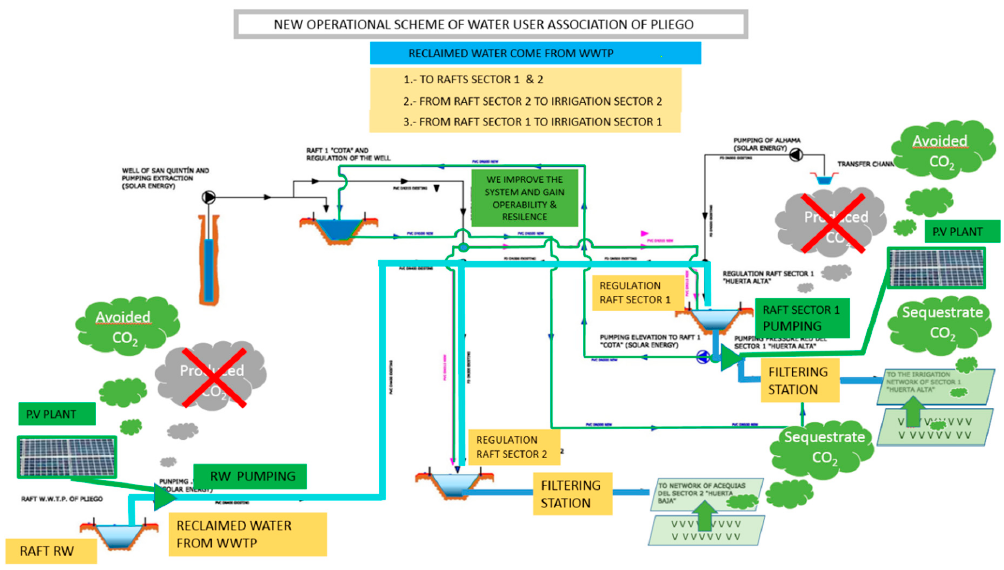
Figure 15. New operational scheme of WUA of Pliego.